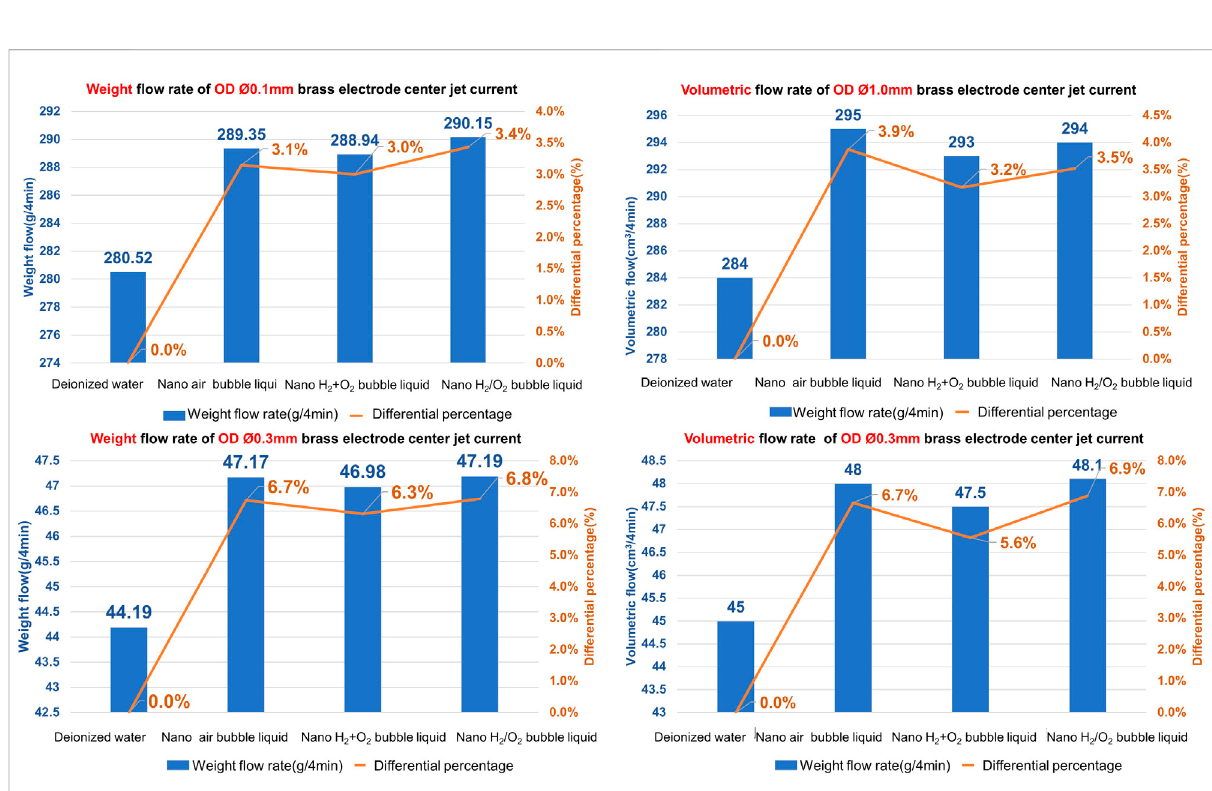
FIGURE 14 The effect of 3 kinds of nanobubble liquids on high-pressure jet fl